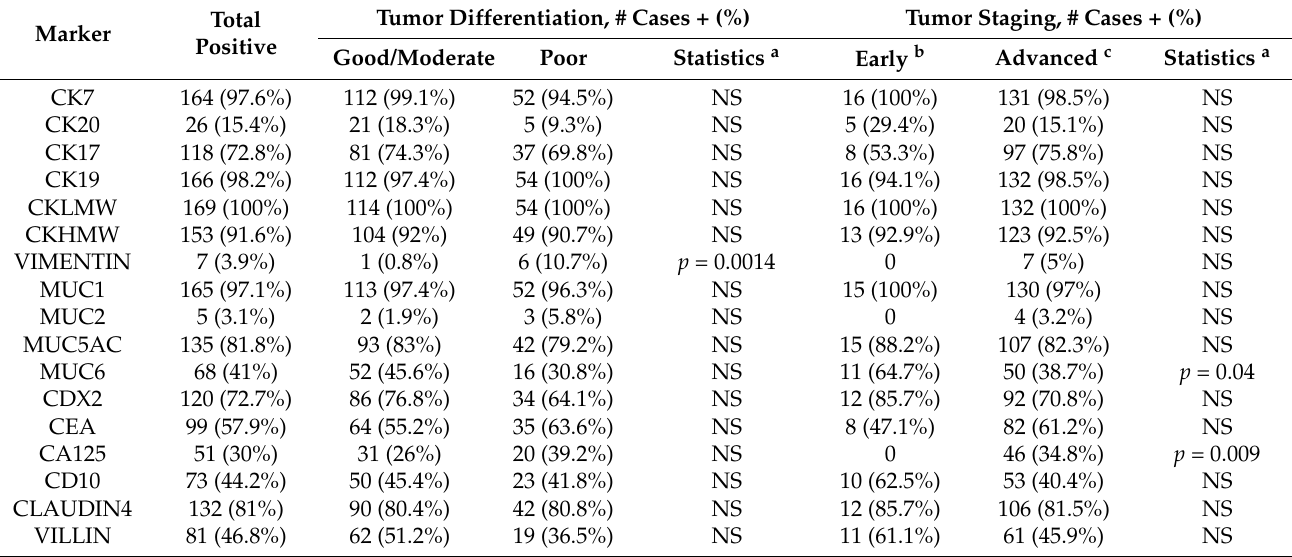
Table 2. Association between tumor marker expression and tumor differentiation status or tumor staging in GBC